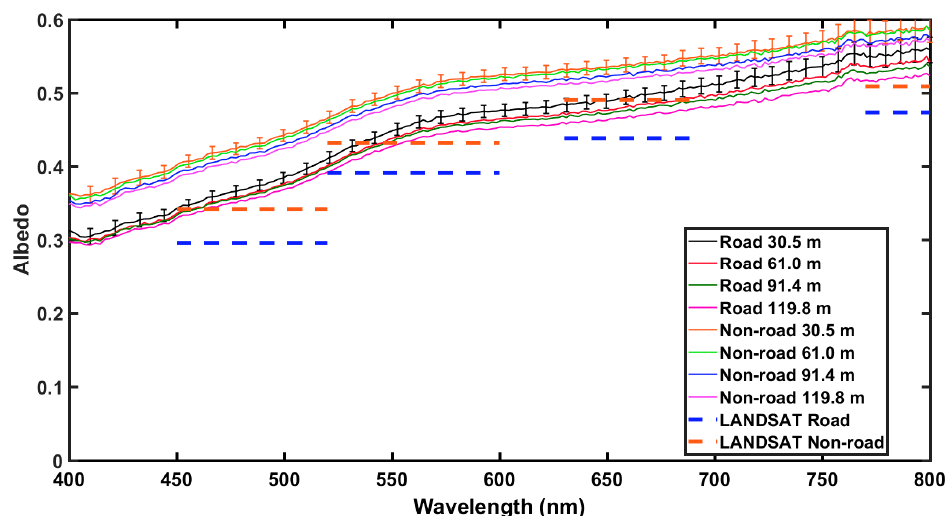
Figure 12. Same caption as Figures 10 and 11 but for Land Satellite 7 (LANDSAT7) Enhanced Thematic Mapper Plus (ETM+).